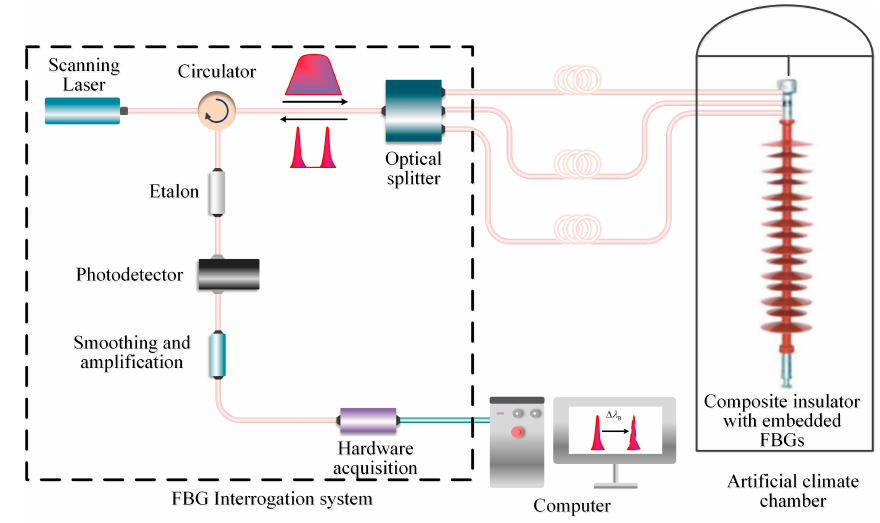
Figure 3. Sensing system of the composite insulator with embedded FBGs.